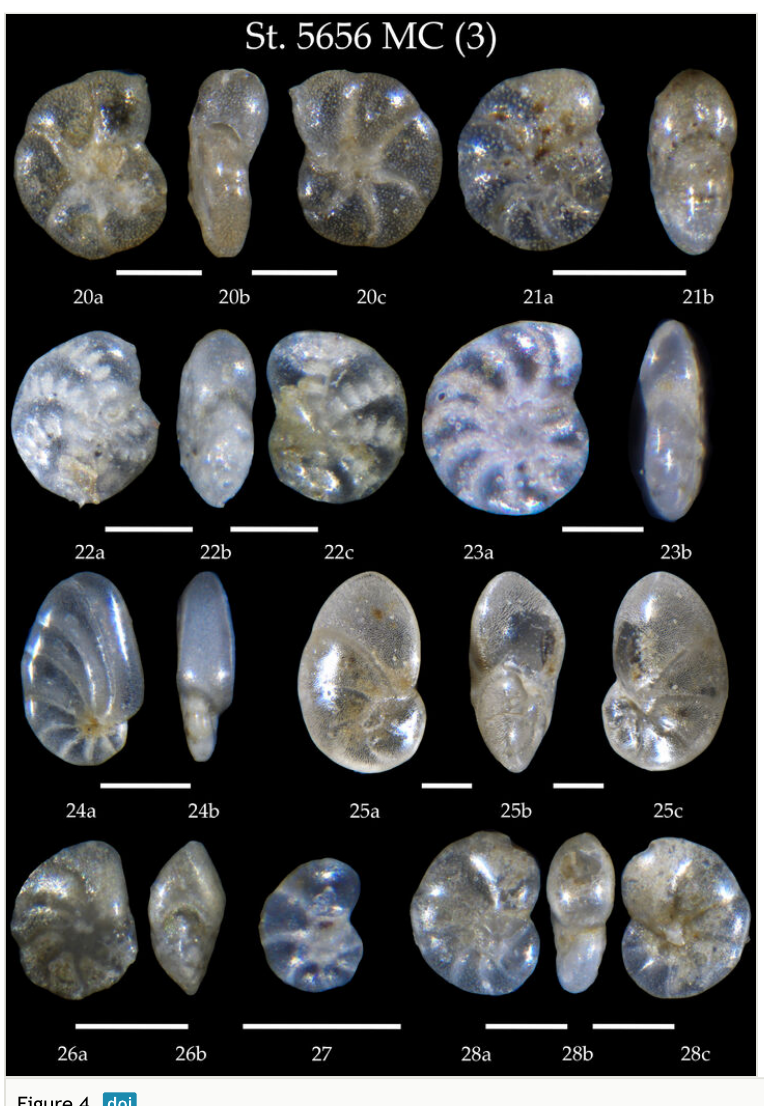
Figure 4. Station 5656 MC (continued). 20 Astrononion gallowayi , a side view, b apertural view, c lateral view; 21 Elphidium clavatum , a side view, b apertural view; 22 Elphidium earlandi , a side view, b apertural view, c lateral view; 23 Elphidium gerthi , a side view, b apertural view; 24 Nonionoides turgidus , a side view, b apertural view; 25 Nonionella iridea , a spiral view, b apertural view, c umbilical view; 26 Nonion pauperatum , a side view, b apertural view; 27 Nonionella auricula ; 28 Nonion sp. cf. N. faba , a spiral view, b apertural view, c umbilical view. Scale 100